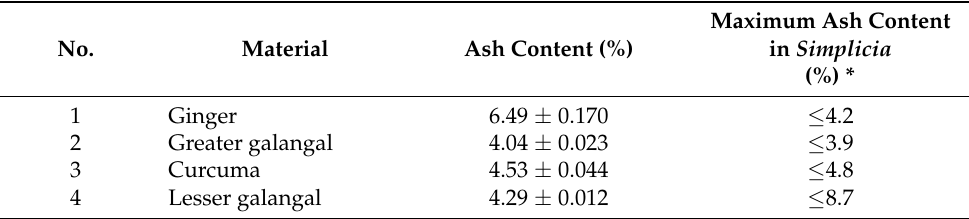
Table 6. Summary of ash content in final products of different medicinal plant samples dried in the Polydryer with the operation of a heater.